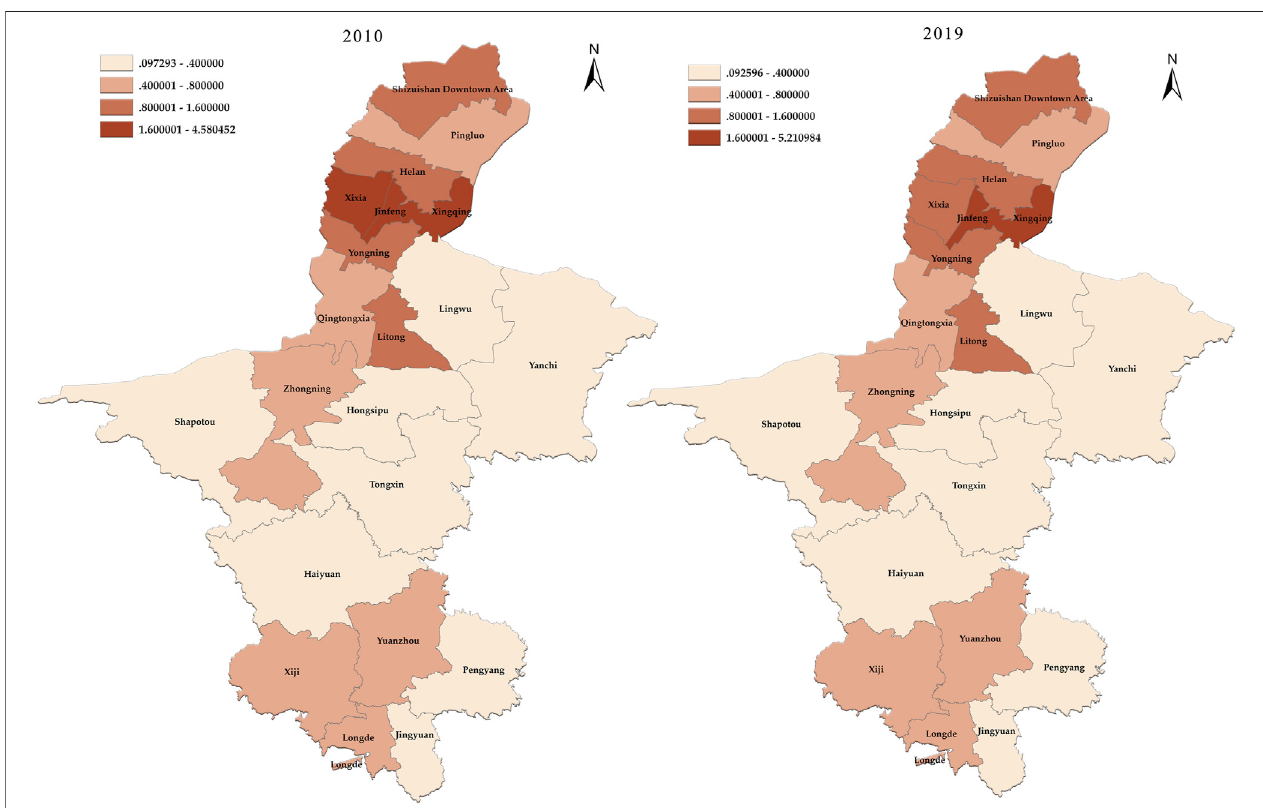
FIGURE 5 | The geographical concentration of Ningxia ’ s population in 2010 and